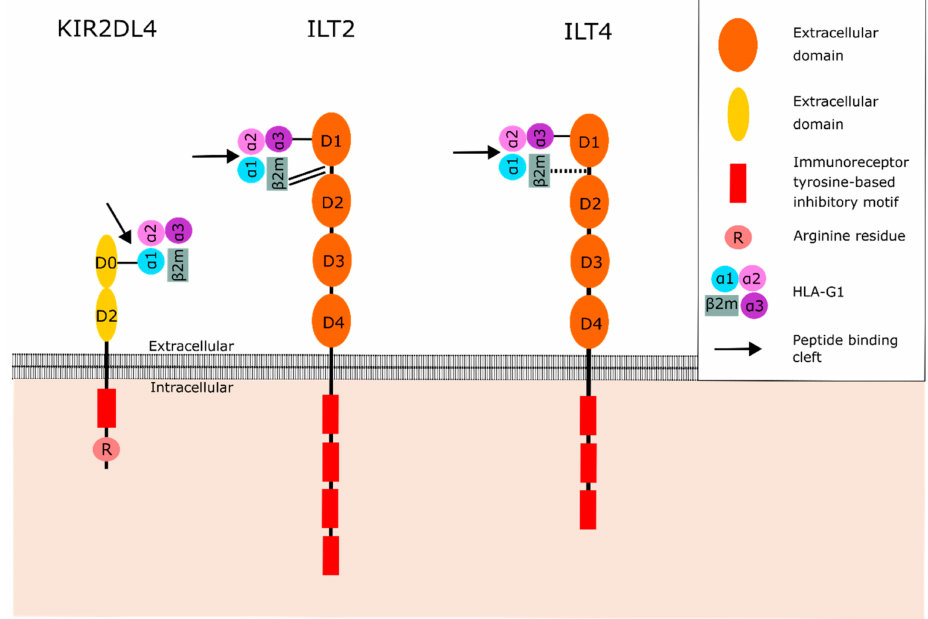
Figure 3. Structure of the HLA-G receptors KIR2DL4, ILT2 and ILT4, and their interaction with HLA-G1. The D0 domain of KIR2DL4 binds to the α 1 domain of HLA-G1, which is part of the peptide binding cleft. However, the peptide is positioned deeper in the binding cleft than the position where KIR2DL4 binds to, suggesting that the peptide is not involved in the binding between KIR2DL4 and HLA-G1. ILT2 and ILT4 bind to the α 3 domain and β 2M, distal to the peptide binding cleft. The peptide is therefore not involved in binding between HLA-G and ILT2 or ILT4. The binding between the receptor and HLA-G is represented by black lines: single line (normal binding), double line (strong binding), dotted line (weak binding). Abbreviations: β 2-microglobulin ( β 2M), human leukocyte antigen G (HLA-G), Ig-like transcript 2 (ILT2), Ig-like transcript 4 (ILT4), Killer cell immunoglobulin-like receptor 2DL4